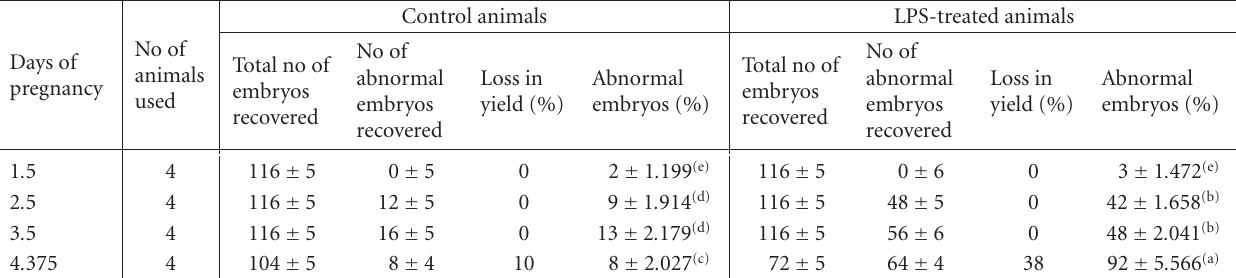
Table 2: E ff ect of the “minimum e ff ective dose” of LPS on development of preimplantation stage embryos collected from superovulated pregnant animals. Data is expressed as mean ± 1 SEM, with all values given in ( % ) of abnormal embryos. Means bearing similar superscripted alphabets do not di ff er from each other at P ≤ . 05 (based on Duncan’s multiple range test). ANOVA : treatment (T), F-value = 959 .